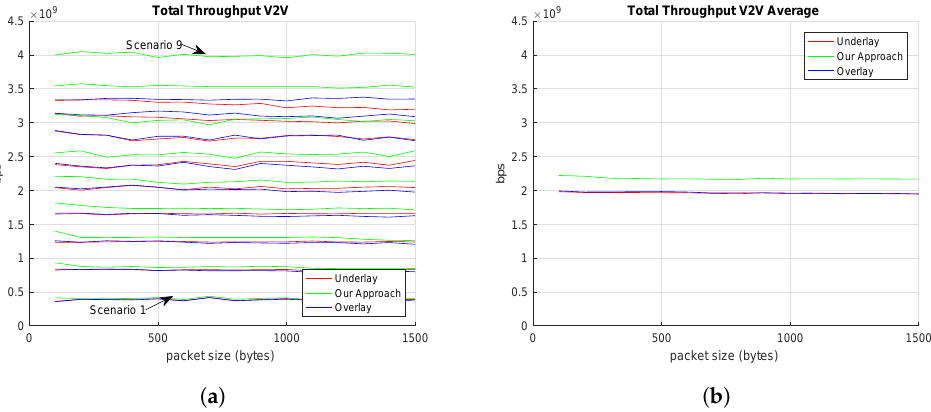
Figure 4. Throughput offered to V-UEs based on C-UEs’ traffic pattern. ( a ) Average Throughput of V-UEs in different scenarios; ( b ) Total Average Throughput of